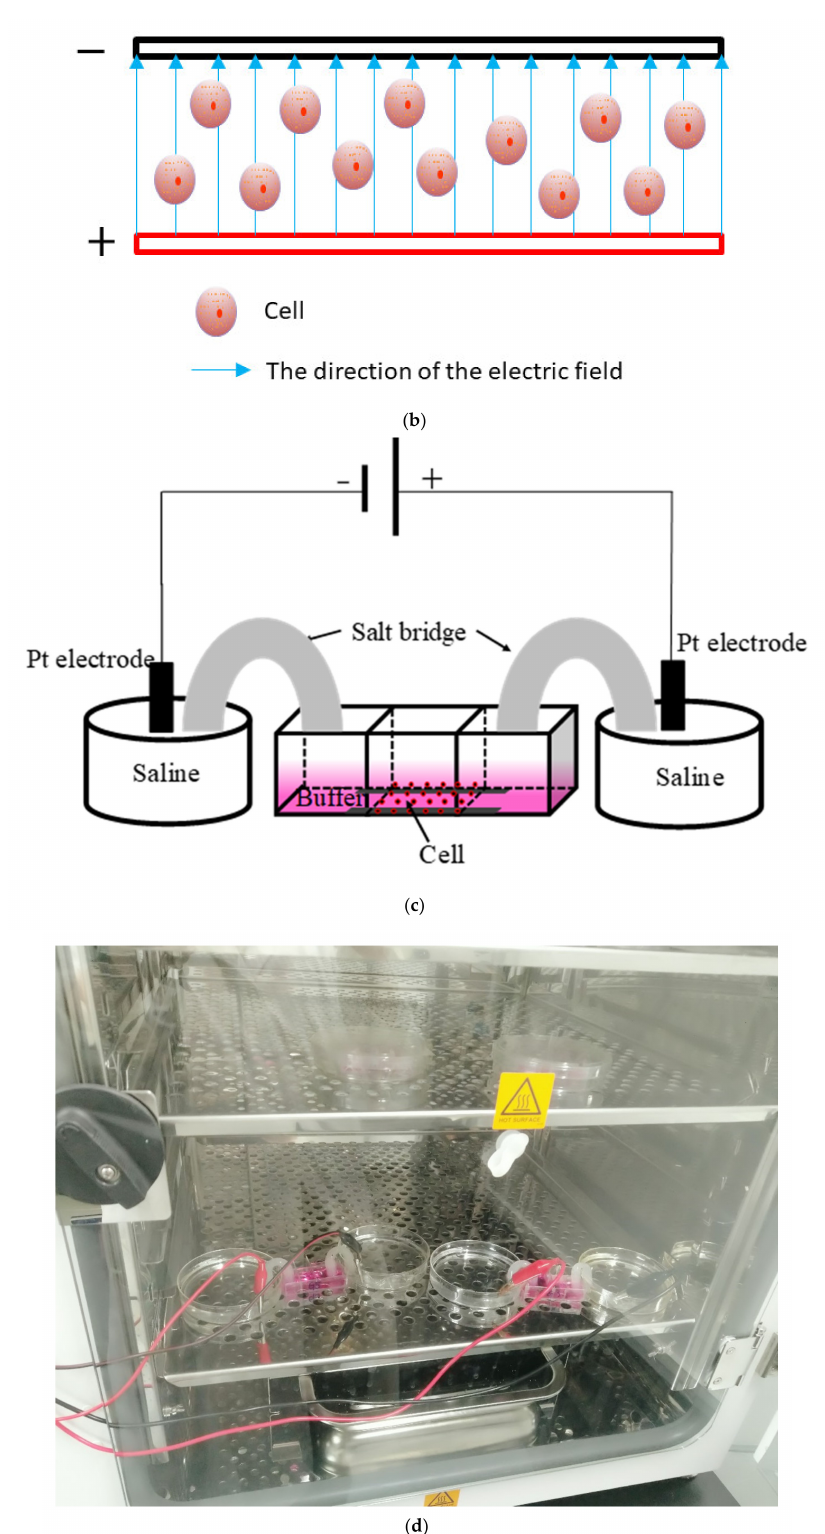
Figure 8. Schematic diagram. ( a ) Study workflow. Red object: cell; blue arrow: direction of electric field. ( b ) The schematic diagram of the movement of cells in the electric field. ( c ) The structure of the chamber. ( d ) The electric field chamber in the